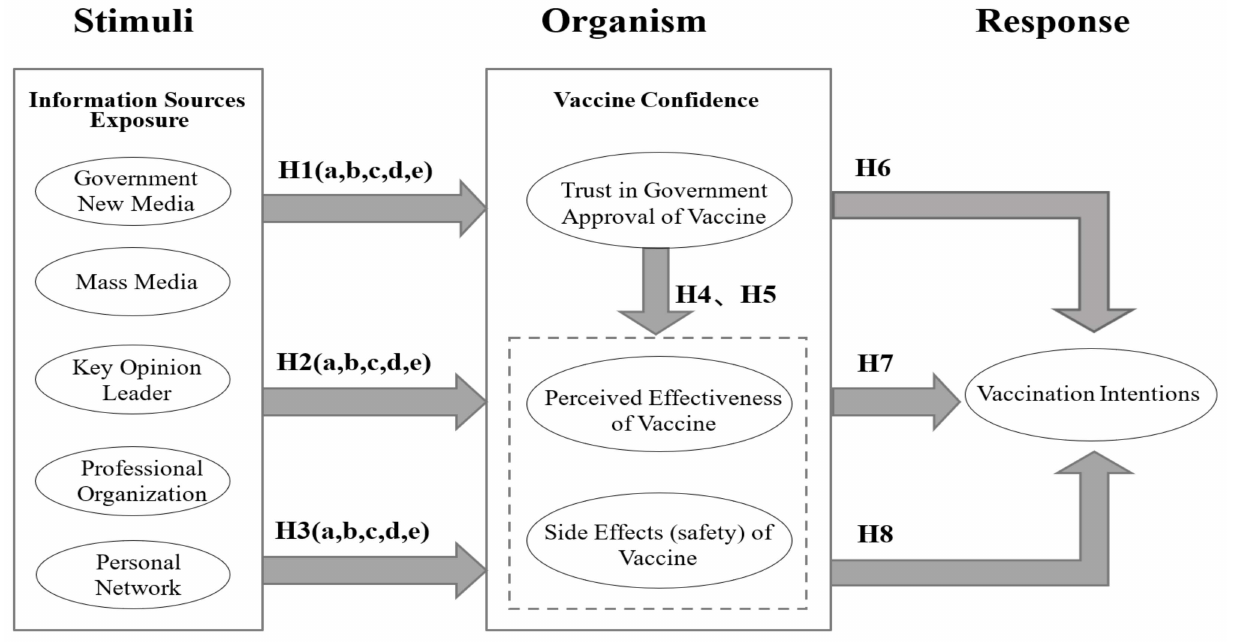
Figure 1. Research model based on the SOR